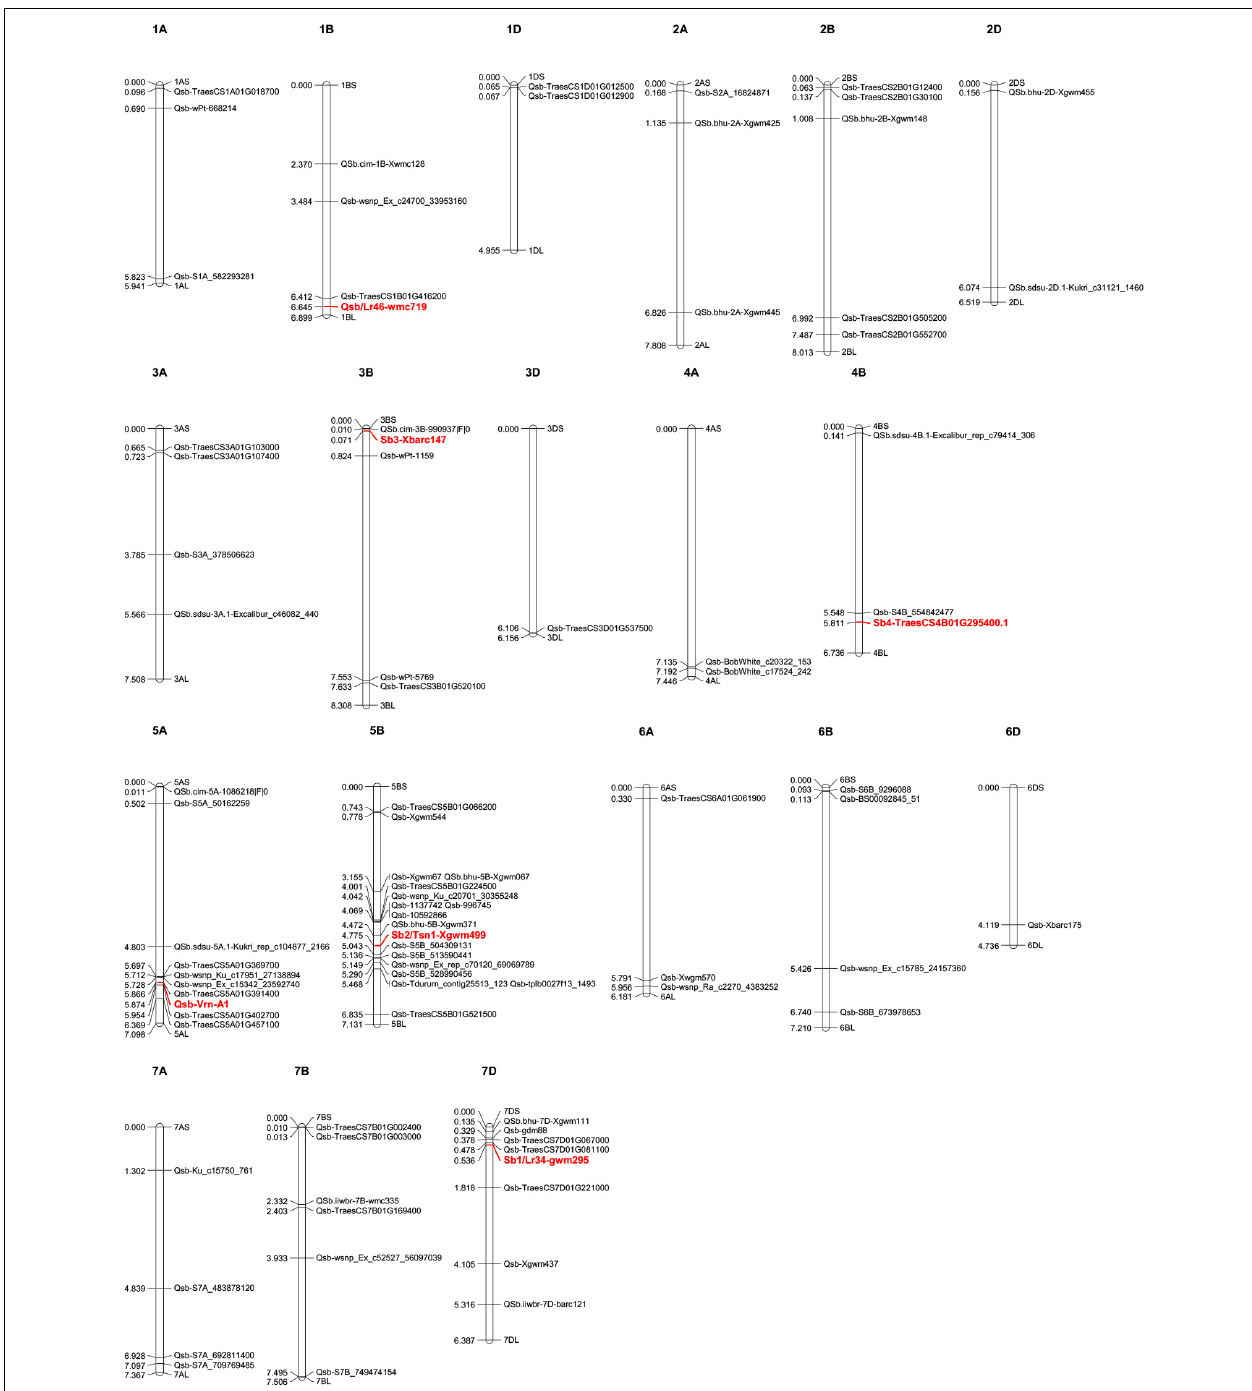
FIGURE 2 | Genetics of resistance to common root rot (spot blotch) in wheat. Molecular markers, SNPs, and genes associated with common root rot or spot blotch resistant QTLs were collected from previous publications and searched against the JBrowse-1.12.3-release of the common wheat “Chinese Spring” genome available from the “ Triticeae Multi-omics Center (http://202.194.139.32/).” Physical positions (numbers indicated on the left side of each chromosome, in units of 100,000,000 bp) were used to generate a distribution map of all the collected QTLs using Mapchart v2.32 software. Stable QTLs with large effect or linked with designated genes are highlighted in red. Detailed information for these QTLs can be found in Table 1